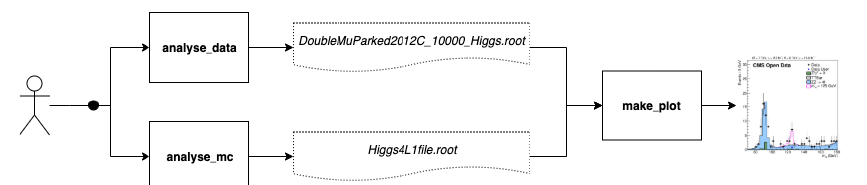
Figure 5. A Higgs-to-four-lepton physics analysis example using CMS open data. [6]. Note two parallel steps, analysing collision and simulated datasets; the results are then combined to make final plot.